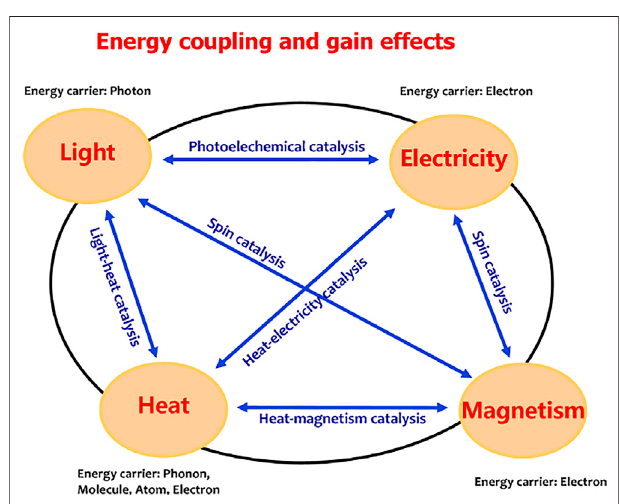
FIGURE 3 | Coupling and gain effects between two common